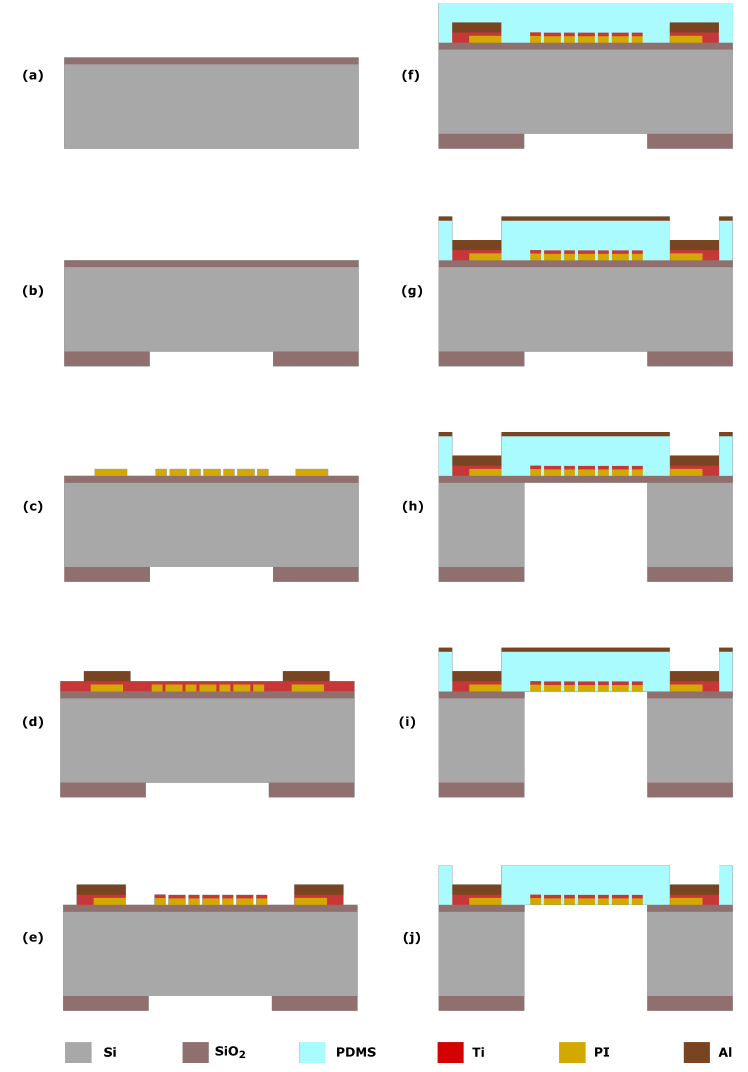
Figure 3. Main steps of the fabrication process for the integration of Ti strain gauges on PDMS membranes. ( a ) Deposition of oxide on the wafer front side. ( b ) Deposition and patterning of the oxide on the wafer back side to define the circular membrane. ( c ) Deposition and patterning of PI layer for electrical and mechanical isolation. ( d ) Deposition of Ti and patterning of electrical contacts (Al). ( e ) Patterning of the metal layer corresponding to the strain gauges (Ti). ( f ) Deposition of PDMS layer. ( g ) Deposition and patterning of the Al masking layer and etching of the PDMS layer to open the electrical contacts. ( h ) Etching of the silicon substrate using a DRIE process. ( i ) Removal of the landing SiO 2 . ( j ) Removal of the masking layer (Al) by wet and dry